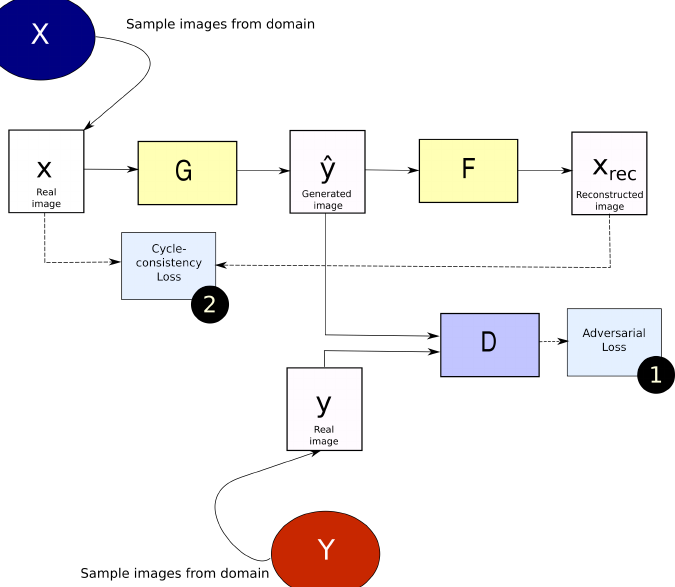
Figure 1. Block diagram of a CycleGAN architecture for the mapping X →